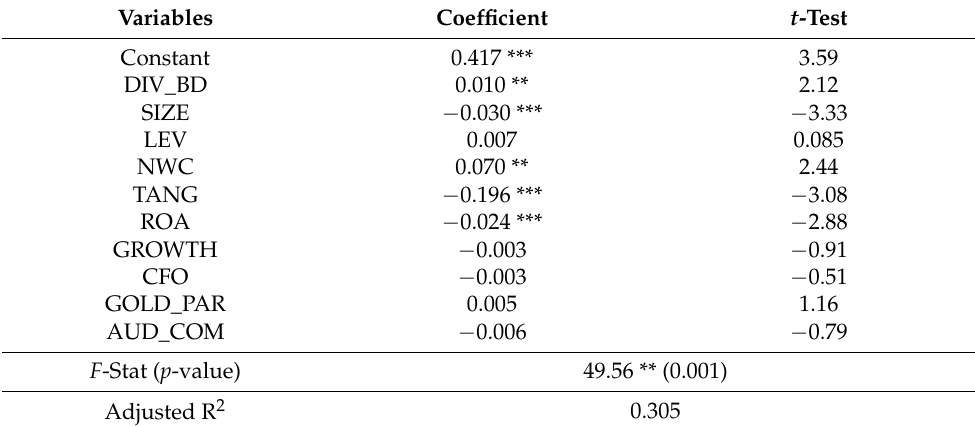
Table 8. Propensity score matching (PSM)